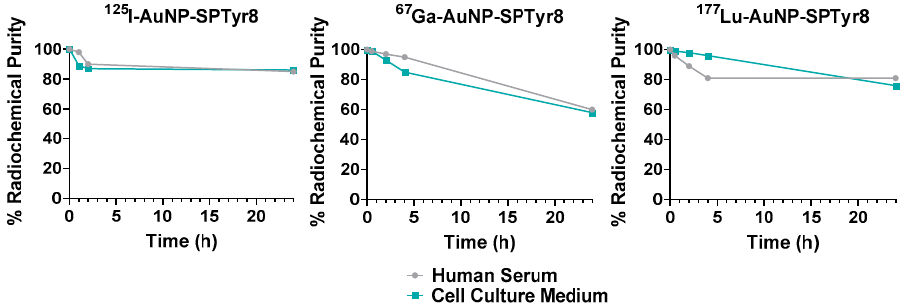
Figure 4. Radiochemical stability of AuNP-SPTyr8 radiolabeled with 125 I, 67 Ga and 177 Lu in the presence of human serum and cell culture medium, at 37 °C.